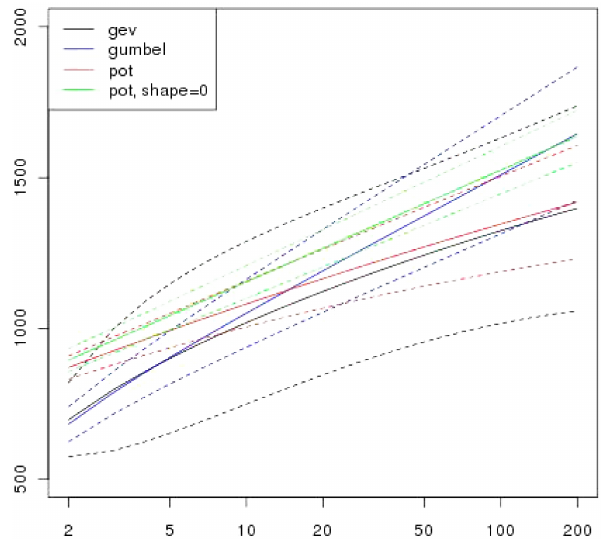
Figure 4. Overall findings with confidence intervals. Horizontal: return times. Vertical: estimated flow